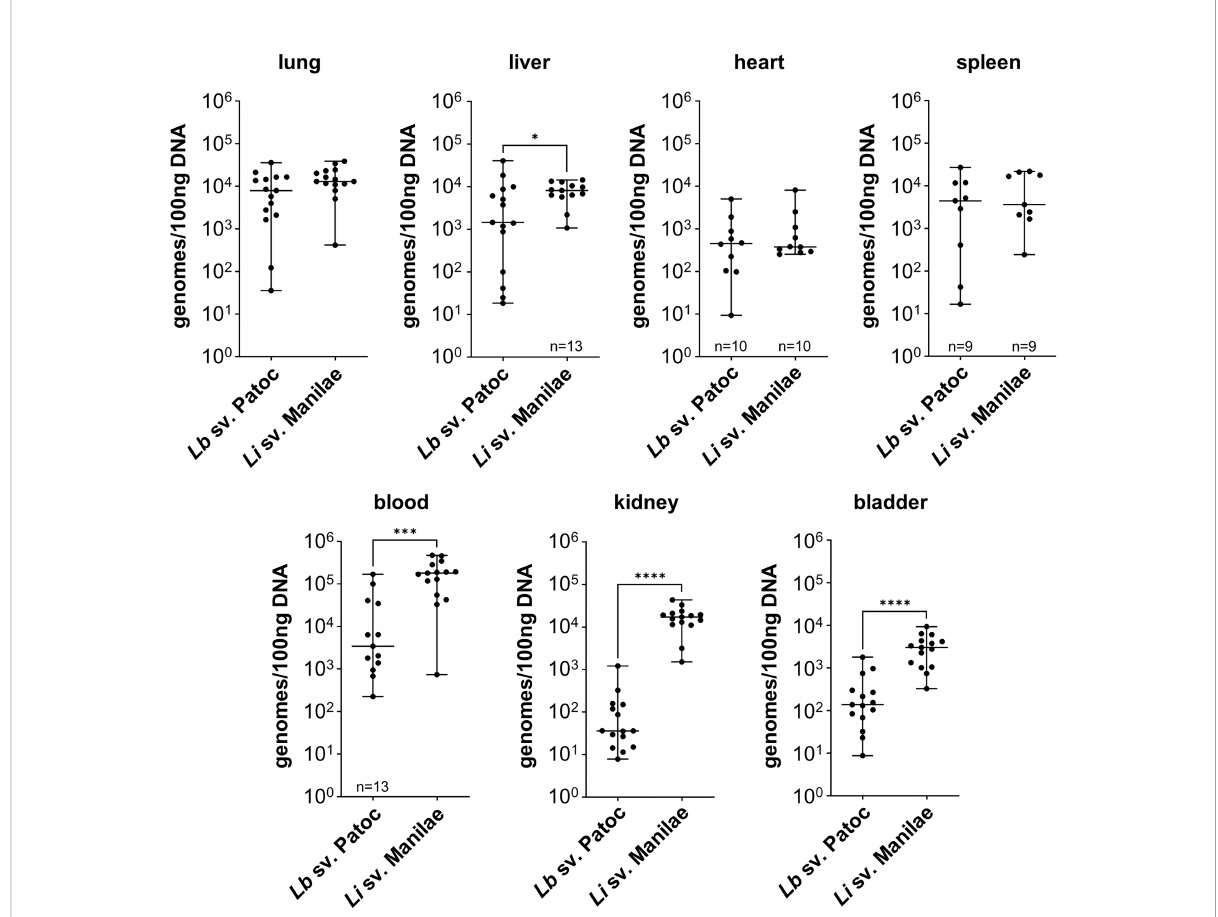
FIGURE 1 Pathogenic Leptospira has a tropism for the liver, kidney, and bladder. Mice were inoculated intravenously in a one-hour model of infection. DNA from tissues was harvested and quanti fi ed by qPCR. Signi fi cantly higher burdens of L. interrogans sv. Manilae were found in the blood, liver, kidney, and bladder compared to non-pathogenic L. bi fl exa sv. Patoc. Data represent a total of fi fteen mice per group unless otherwise noted, performed as three independent experiments per strain. Heart and spleen samples were only harvested from two of the three experiments. Median ± range is plotted. * denotes p ≤ 0.05, *** denotes p ≤ 0.001, **** denotes p ≤